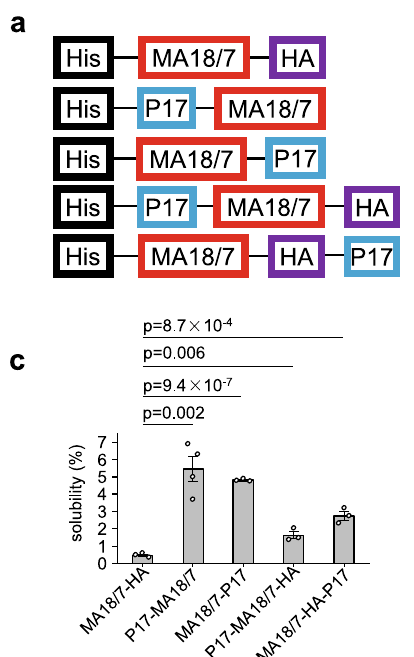
Fig. 2 | P17 tag signi fi cantly improved solubility of scFv in SHuf fl e T7 strain regardless of fusion positions. a Schematic diagrams of His-MA18/7-scFv-HA proteinand itsN- and C-terminally P17-tagged derivatives with a C-terminalHAtag fusion or not. b Determination of solubility of His-MA18/7-scFv-HA protein and its derivatives expressed in SHuf fl e T7 cells by western blotting. The result of one representative experiment was shown. T, total protein; S, soluble